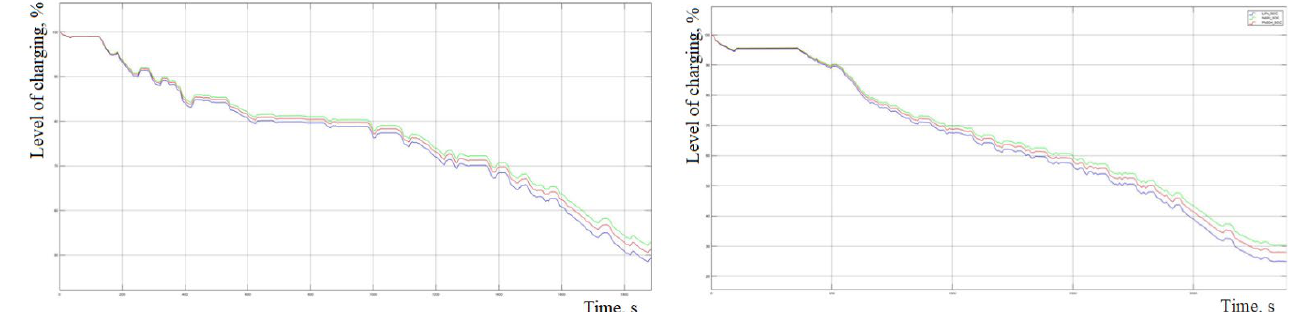
Fig. 7. Discharge levels of different accumulators of routes No. 5 and No. 2. Green – nickel-metal hydride, red – lead acids; blue – lithium-ion.